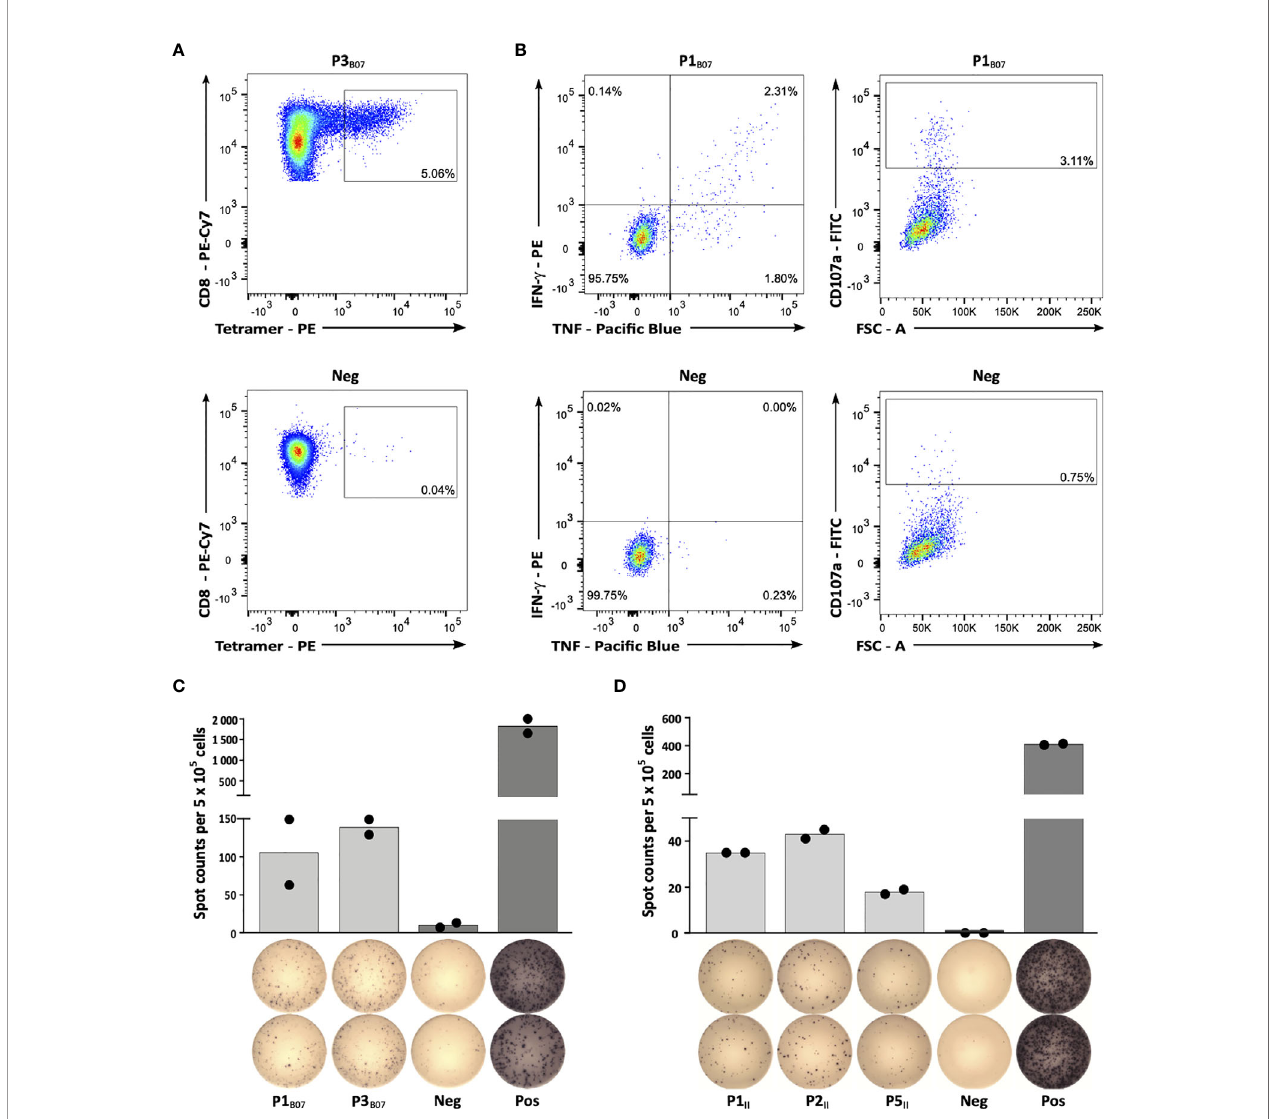
FIGURE 3 | Immunogenicity analyses of CLL-associated peptides. (A) Representative example of P3 B07 -speci fi c tetramer staining of CD8 + T cells after 4 cycles of aAPC-based in vitro priming. Graphs show single, viable cells stained for CD8 and PE-conjugated multimers of indicated speci fi city. The upper panel displays P3 B07 -tetramer staining of T cells primed with P3 B07 . The lower panel (negative control) depicts P3 B07 -tetramer staining of T cells from the same donor primed with an HLA-matched irrelevant control peptide. (B) Functional characterization of induced P1 B07 -speci fi c CD8 + T cells after in vitro aAPC-based priming by intracellular cytokine (IFN- g , TNF) and degranulation marker (CD107a) staining. Representative example of IFN- g and TNF production as well as CD107a expression after stimulation with the peptide P1 B07 compared to an HLA-matched negative control peptide. (C, D) Representative examples of preexisting T cell responses to (C) HLA-B*07- and (D) HLA class II-restricted peptides as evaluated by IFN- g ELISpot assays after 12-day in vitro expansion using PBMC samples of CLL patients (C, UPN064; D, UPN066). Data are presented as scatter dot plot with mean. FSC, forward scatter; Neg, negative control; Pos, positive